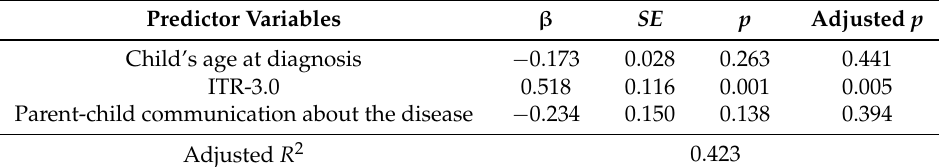
Table 6. Factors related to Long-term Uncertainty of the parents by multiple regression